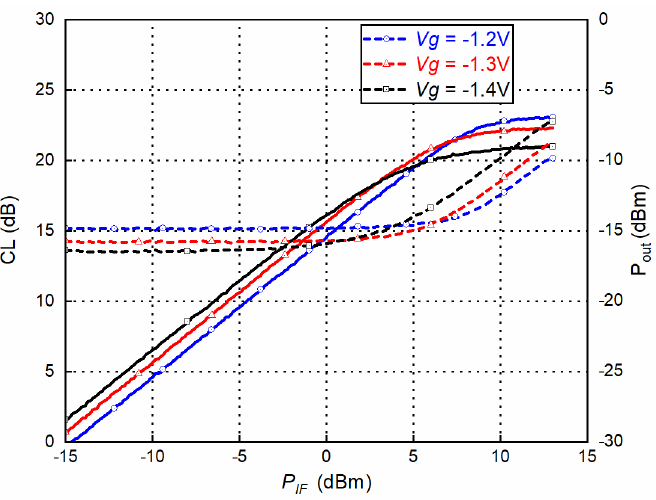
Figure 17. Conversion loss (CL) and output power vs. input power at 160 GHz. (LO @ 13 dBm).